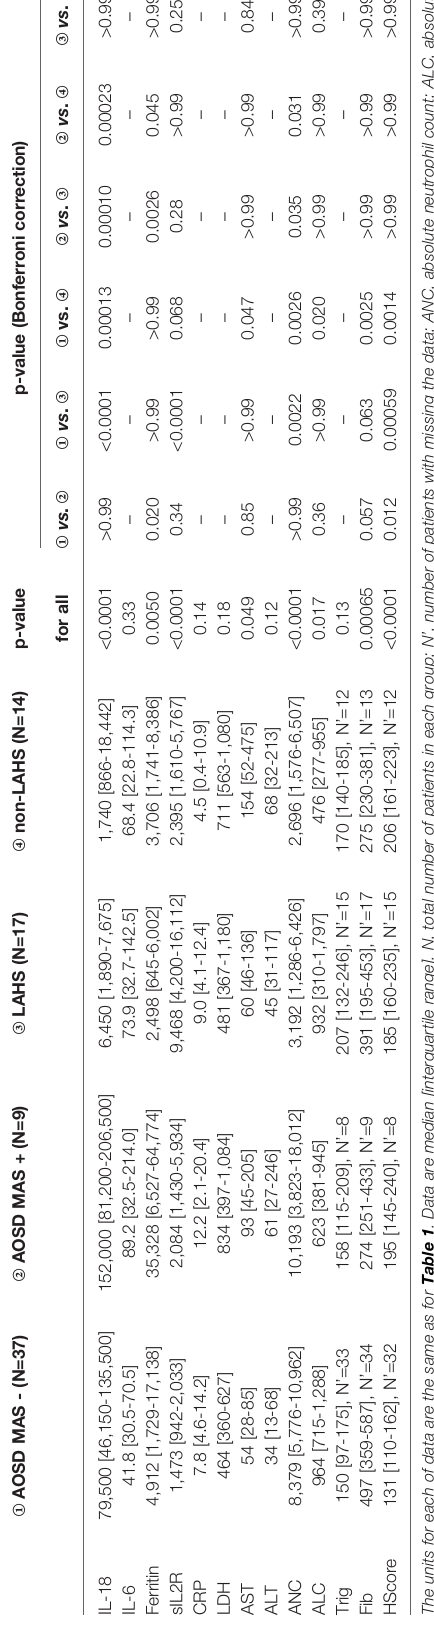
We also analyzed the correlations between IL-18 and other laboratory data in the AOSD patients ( Figure 3 ). The IL-18 levels in serum were strongly correlated with sIL-2R (r=0.62, p<0.0001, Figure 3A ), ferritin (r=0.79, p<0.0001, Figure 3B ), LDH (r=0.85, p<0.0001, Figure 3C ), AST (r=0.56, p<0.0001, Figure 3D ), Trig (r=0.57, p=0.0005, Figure 3F ) and HScore (r=0.72, p<0.0001, Figure 3H ), and weakly associated with ALT (r=0.37, p=0.012, Figure 3E ). In addition, IL-18 and Fib showed a negative correlation (r=-0.45, p=0.0078, Figure 3G ). In contrast, IL-18 was not correlated with IL-6, C-reactive protein, ANC and ALC (data not shown). T A